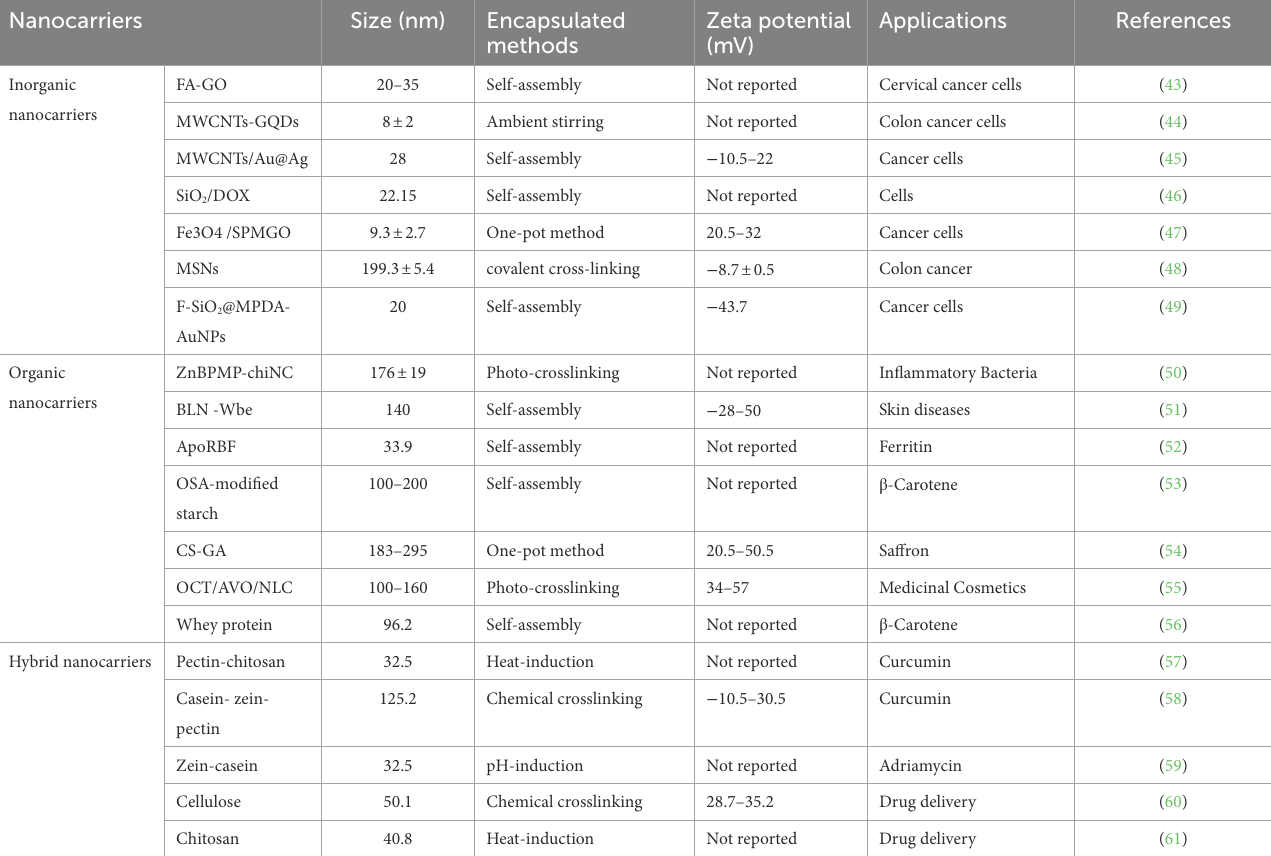
TABLE 1 Comparison and application of different nanomaterials.